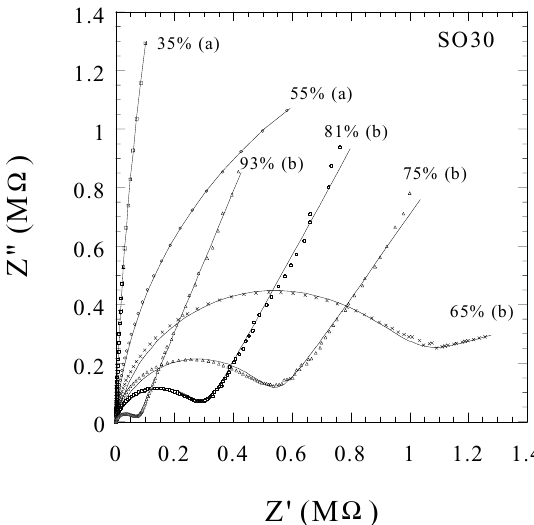
Figure 10. Cole-Cole plot of sensor SO30 at different humidity levels. The points represent the experimental data and lines the fit with the equivalent circuit model given in Figure 12. The RH values at which the data was collected and the equivalent circuit used for fitting each curve (given as (a) or (b) denoting the circuit of Figure 12a and 12b respectively) are shown adjacent to each curve.